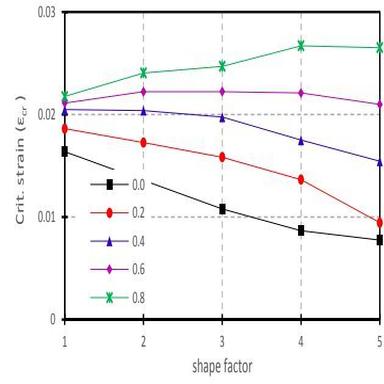
Plot of εcr vs. shf for YPT X70 pipe (D/t = 41.152).